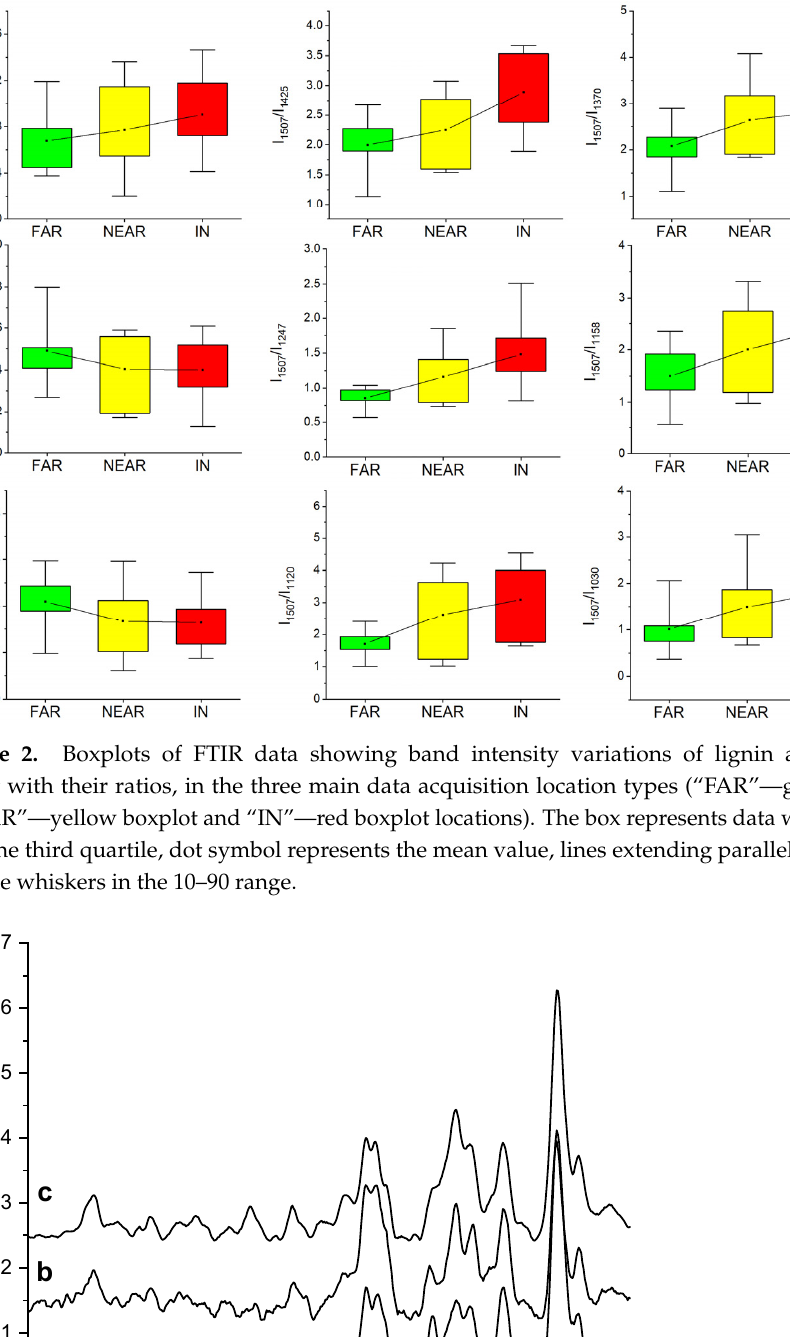
Figure 3. Raman spectra (SNV and baseline corrected) of chestnut samples collected inside ( a ), near ( b ) and far ( c ) from the shallow landslide location.